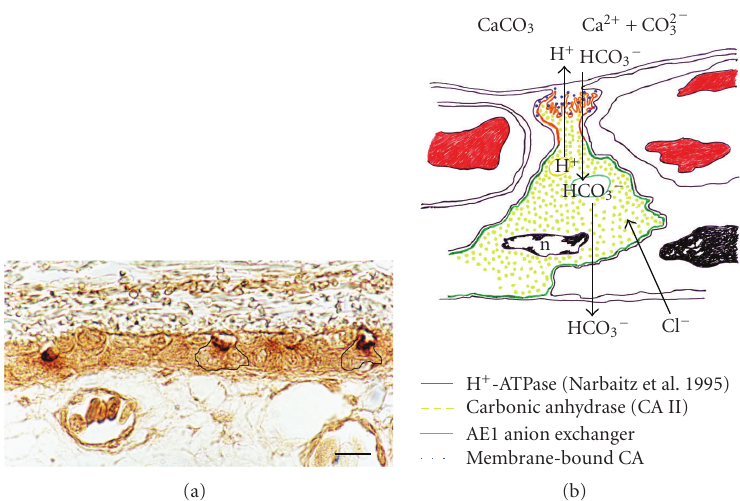
Figure 5: (a) Anti-CAIV staining at the apical cell membrane of the VC cells in the chick CAM at 17 day of incubation. Original magnification: 100x; scale bar: 5 μ m. (b) A schematic representation of the functional model proposed for the VC cells in bicarbonate absorption for acid-base balance in the embryo. M. G. Gabrielli,